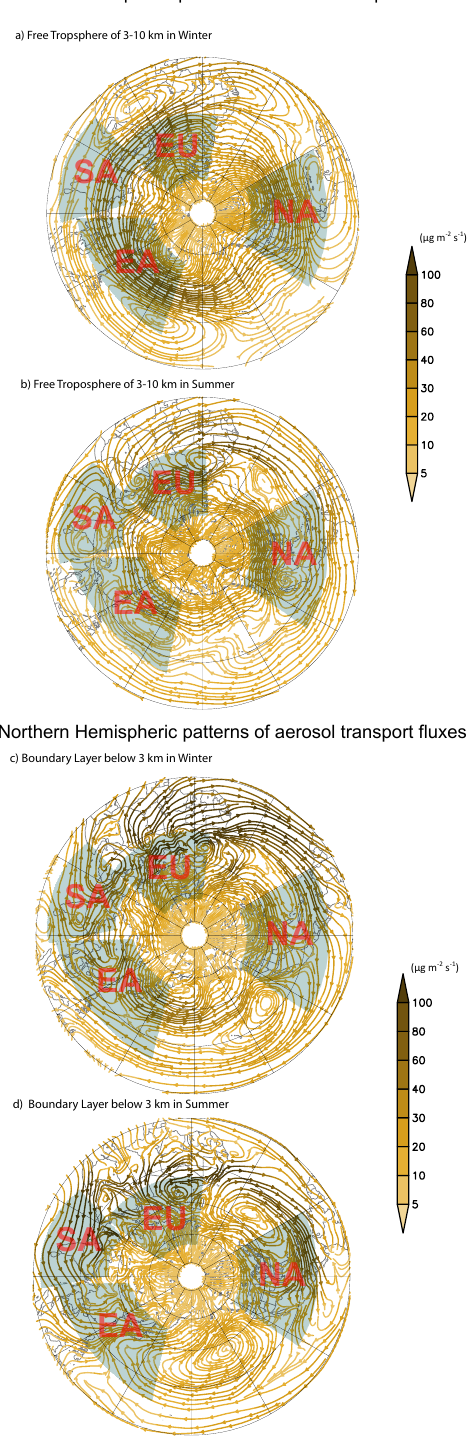
Fig. 7. Northern Hemispheric patterns of aerosol transport fluxes (µgm − 2 s − 1 ) averaged in the free troposphere between 3 to 10km (a) in winter and (b) summer as well as within the boundary layer below 3km (c) in winter and (d) summer over 1995–2004. The col- ored boxes indicate four HTAP-regions (Table